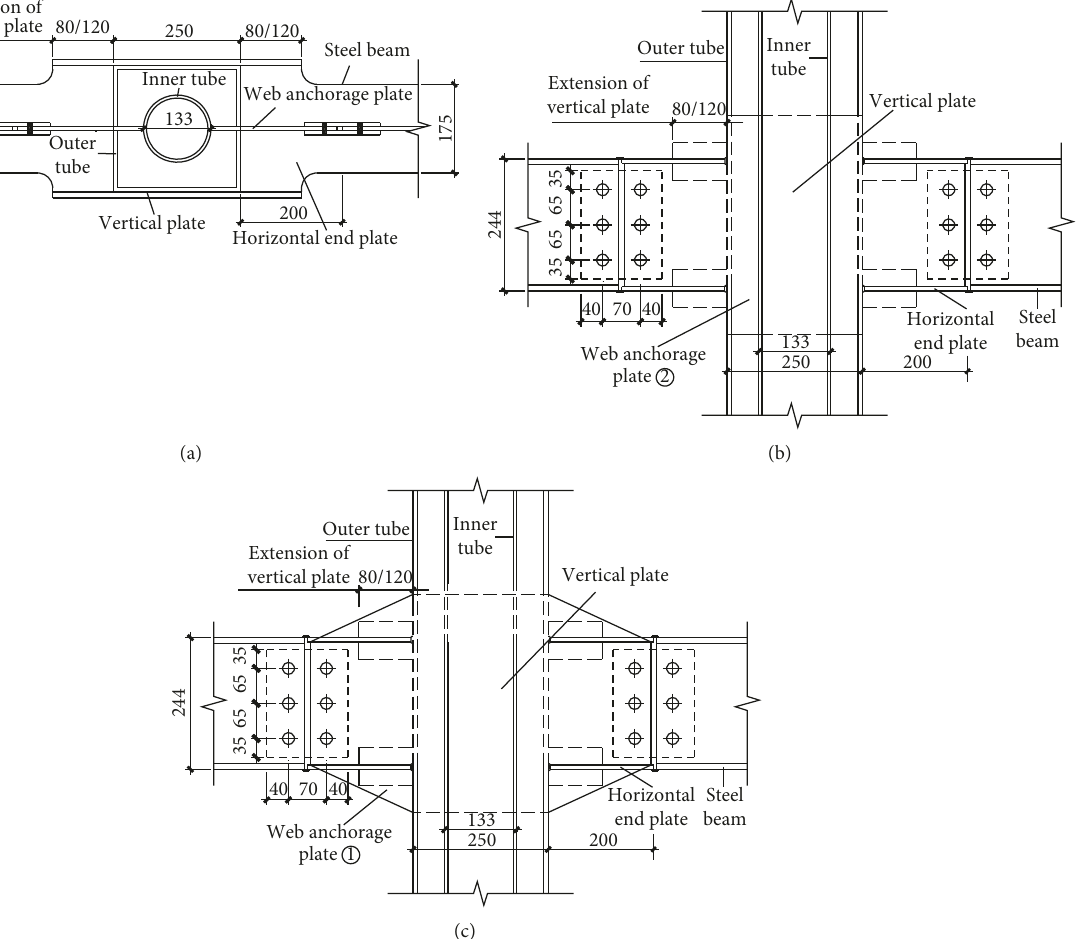
Figure 2: Details of the joint specimens. (a) Plan view of a specimen. (b) Elevation view of the SBJ1-1 and SBJ1-2 specimens. (c) Elevation view of the SBJ2-1 and SBJ2-2 specimens.